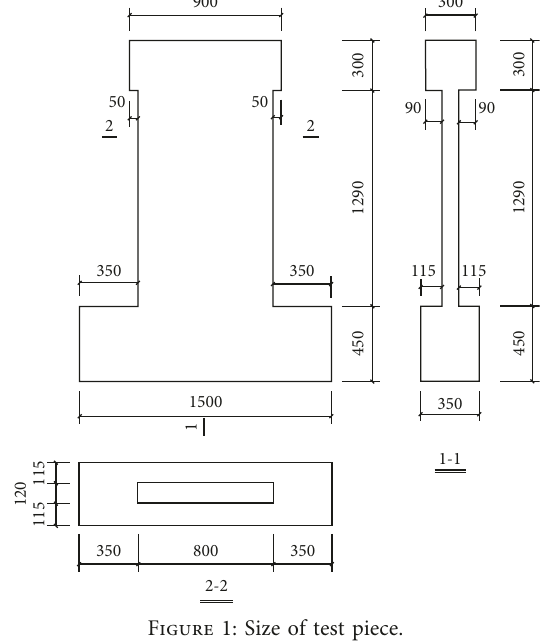
Figure 1: Size of test